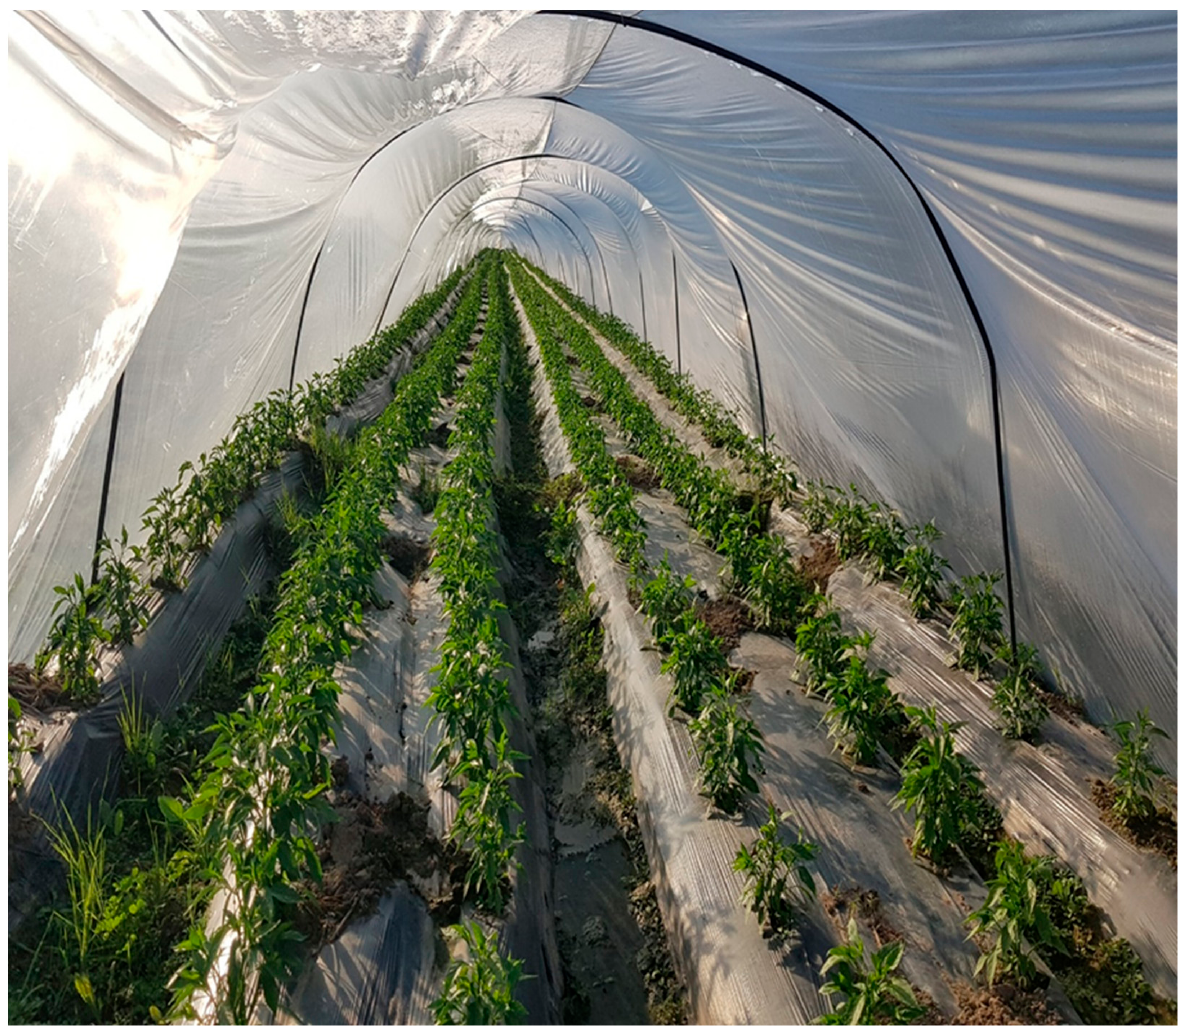
Figure 1. Tunnel structure in Punjab, Pakistan.